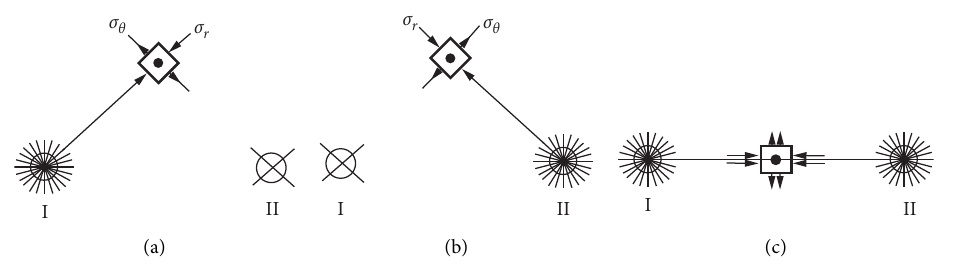
Figure 1: The stress action between